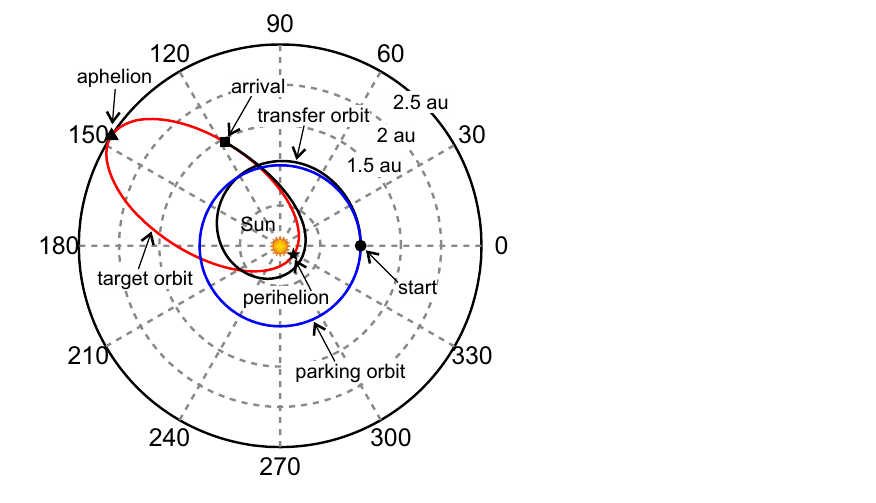
Figure 6. Minimum-time transfer trajectory to reach the heliocentric desired orbit (case a).